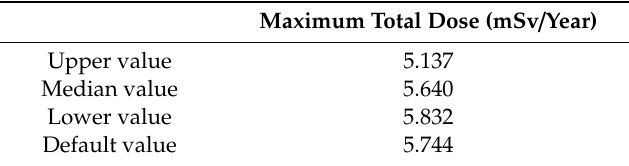
Table 7. Maximum total dose derived by deterministic